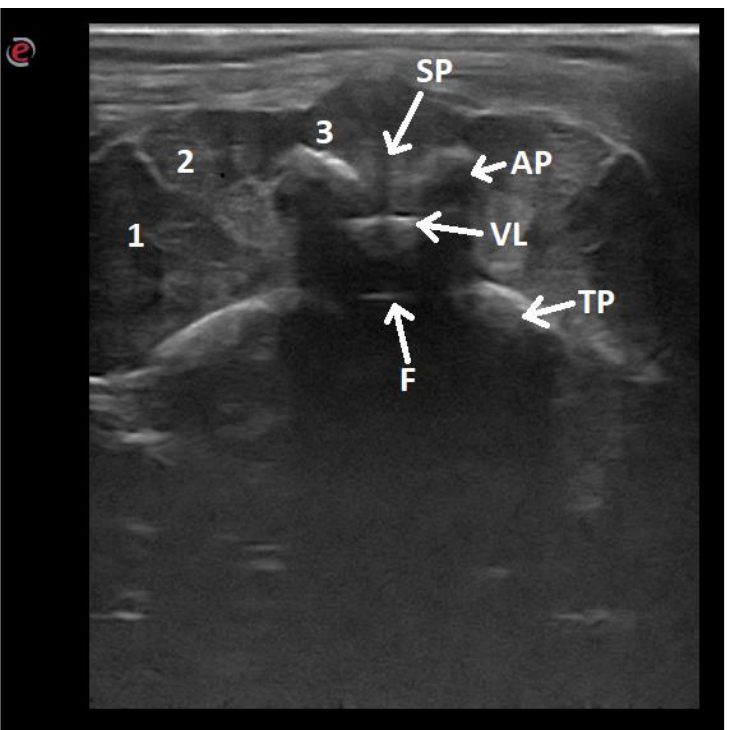
Figure 7. Ultrasonographic image of the lumbar vertebra of a dog in the transverse midline plane: 1 — iliocostalis and longissimus muscles; 2 — spinalis and semispinalis muscle; 3 — multifidus muscle; SP — spinal process; AP — articular process; VL — vertebral lamina; TP — transverse process; F — floor of the vertebral canal.